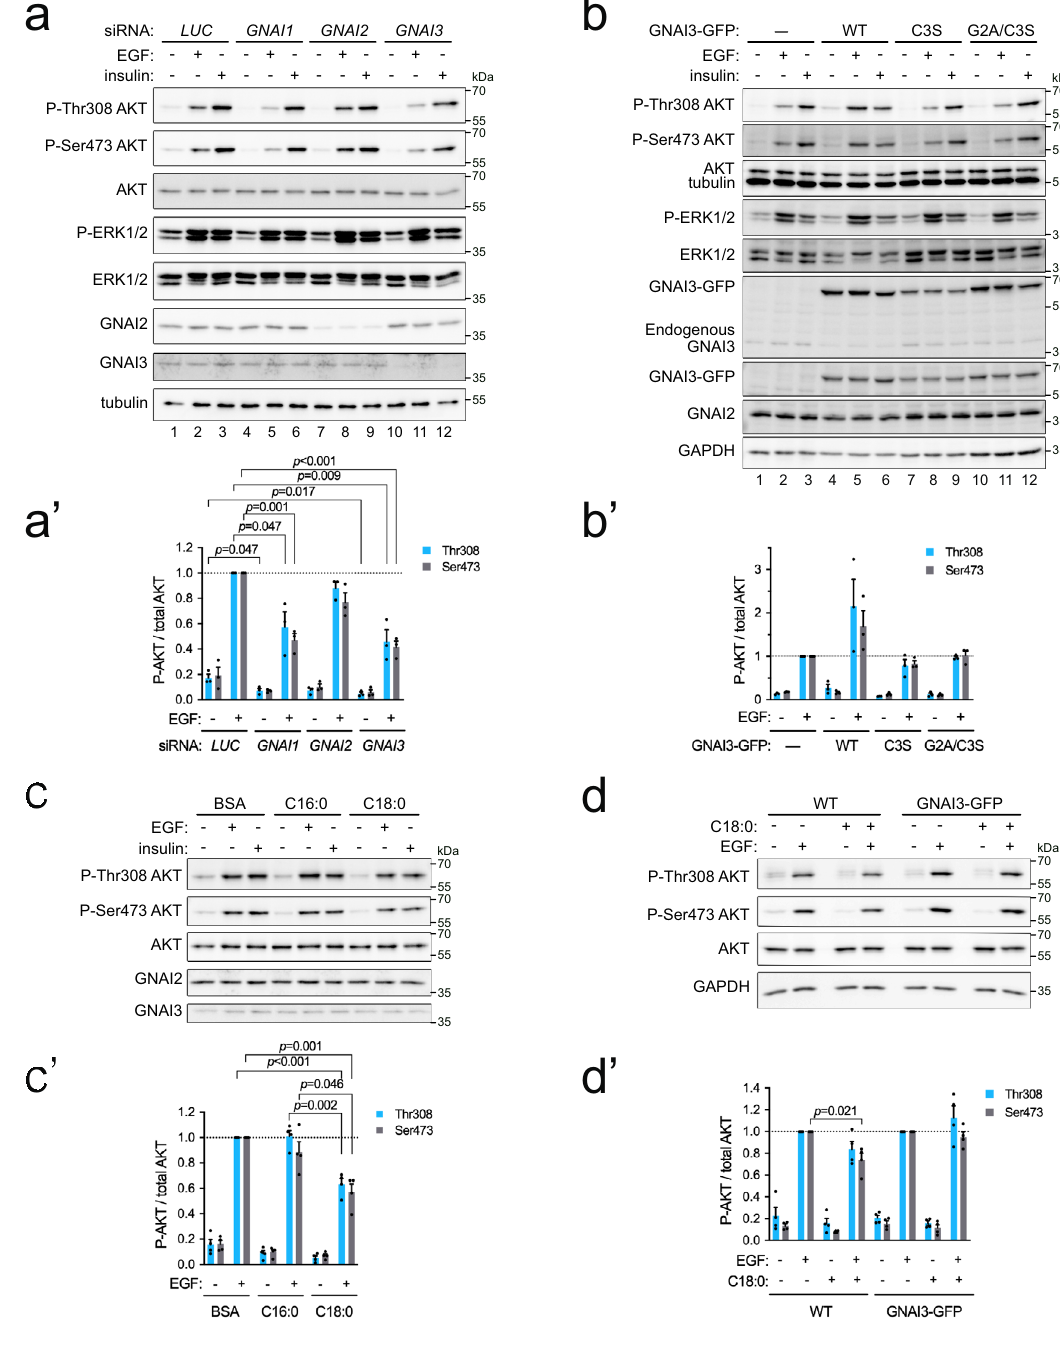
Fig. 6 Exposure of cells to C18:0 reduces AKT activation in response to EGF. a – a ′ GNAI1 and GNAI3 are required for maximal AKT activation in response to EGF. Two days after siRNA transfection, cells were treated with 50 ng/mL EGF or 300 ng/mL insulin for 10 min at 37 °C. Quanti fi ed in ( a ′ ): Data represent mean ± SEM of three biological replicates, p -values were determined by two-sided t -test with correction for multiple comparisons using the Holm – Sidak method. b – b ′ GNAI3 needs to be S-acylated to potentiate EGFR signaling. Overexpression of wild-type GNAI3-GFP but not mutants lacking S- acylation enhances AKT activation in response to EGF. As a control, the parental cell line ( — ) from which the stable GNAI3-GFP expressing cell lines were derived, is used. Quanti fi ed in ( b ′ ): mean ± SEM of three biological replicates. c – c ′ Exposure of cells to stearic acid suppresses EGF-induced activation of AKT. Cells treated 24 h with 100 µ M BSA-conjugated stearate (C18:0) or palmitate (C16:0). Quanti fi ed in ( c ′ ): mean ± SEM of four biological replicates, p - values determined by two-sided t -test with correction for multiple comparisons using the Holm – Sidak method. d – d ′ Stable overexpression of GNAI3-GFP rescues the effect of C18:0 on AKT activation. Cells were incubated with C18:0 (100 µ M, 24 h) and then treated with 50 ng/mL EGF for 10 min. As a control, the parental cell line (WT) from which the stable GNAI3-GFP expressing cell line was derived, is used. Quanti fi ed in ( d ′ ): mean ± SEM of four biological replicates, p -values determined by two-sided t -test with correction for multiple comparisons using the Holm – Sidak